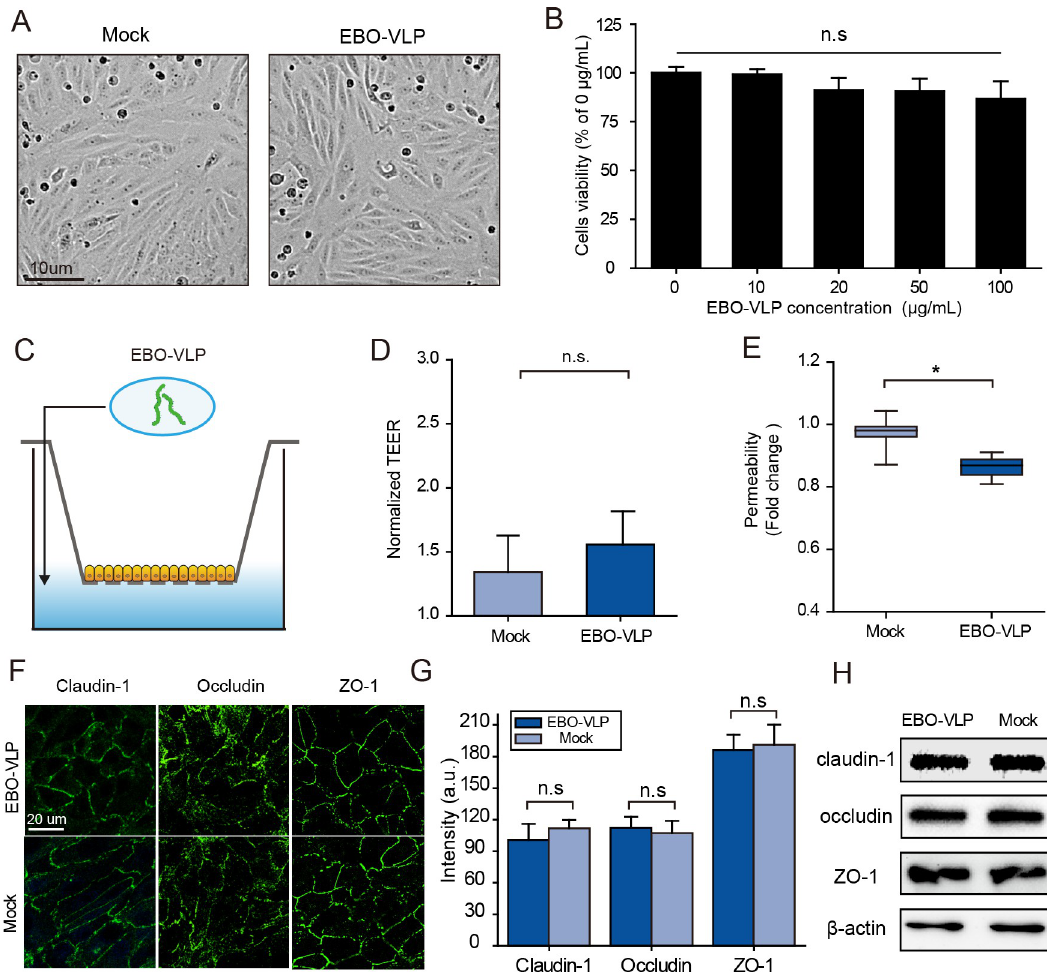
Fig 2. iBRB breakdown by EBO-VLPs is not attributable to direct cytotoxicity on HRECs. (A) Phase contrast images of retinal endothelial cell mono-layers with or without 48 h of EBO-VLP stimulation. Representative images of three independent experiments are shown. (B) Viability of HREC treated with different concentrations of EBO-VLPs. All data were normalized to the mock group. The results are presented as the means ± standard deviation of three independent experiments. (C) Experimental schematic of EBO-VLPs addition to the mono-culture iBRB model. (D-E) Changes in the integrity of the mono-culture iBRB model after EBO-VLP administration. Na-F permeability (D) and the TEER values (E) of the iBRB model were examined 48 h after EBO-VLP administration. TEER values were normalized to those of iBRB models themselves before EBO-VLP administration. The box and the whisker present the median ± percentiles (25–75%) and range, respectively. The fold change of permeability compared with iBRB model itself before EBO-VLP administration is presented as the mean ± standard deviation. All values were determined in six independent experiments. (F) Images of HRECs in the mono-culture iBRB model showing the expression of claudin-1, occludin, ZO-1 (green) and cell nuclei stained with DAPI (blue). Representative images of three independent experiments are shown. The fluorescent images were taken with a 60 × magnification objective lens under a confocal microscope. (G) Quantification of the fluorescence intensity of claudin-1, occludin, and ZO-1 after EBO-VLP administration. The regions for fluorescence intensity were determined in four independent experiments. (H) Western blot analysis of claudin-1, occludin and ZO-1 expression in HREC 48 h after EBO-VLP administration in mono-culture iBRB models. Representative images of three independent experiments are shown. Statistical analysis was performed using Student’s t test. � p < 0.05, �� p < 0.01. Na-F permeability (80.5 ± 1.2 nm � s -1 ) to verify its integrity (S3A and S3B Fig). The tight junc- tion proteins claudin-1, occludin and ZO-1 between HRECs were examined (S3C Fig). After 50 μ g/mL of EBO-VLPs were added to the lower chamber of the model (Fig 2C), the endothe- lial permeability showed no apparent increase during the following 2 days (Fig 2D). The TEER showed only a 14% decrease (Fig 2E), which was much lower than that in the tri-culture model